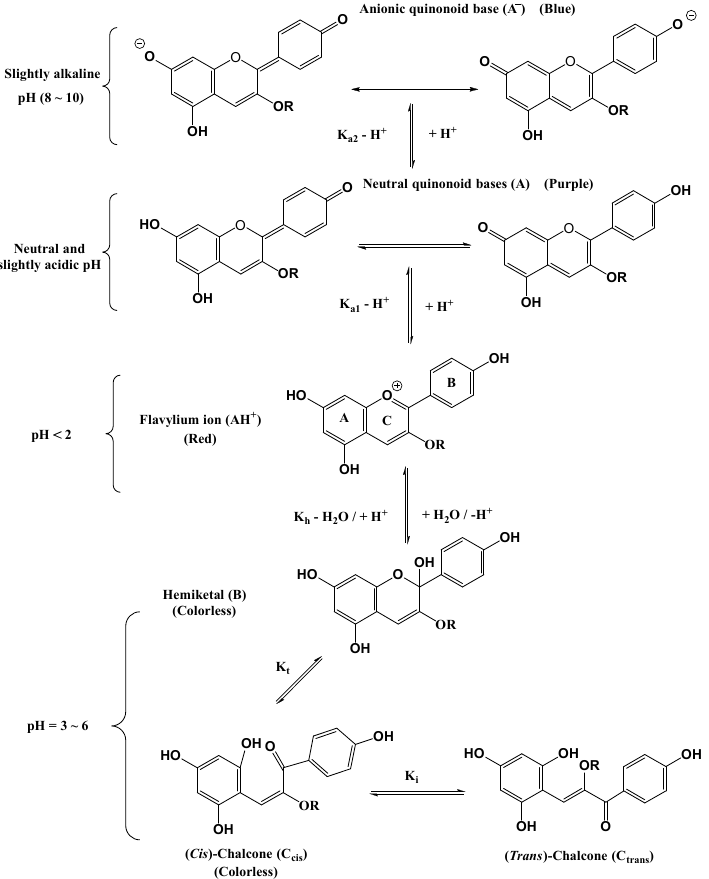
Figure 4. Structural transformations of anthocyanins in acidic to neutral solutions [39]. Reproduced with permission from Trouillas, P, Chem. Rev. ; published by ACS,